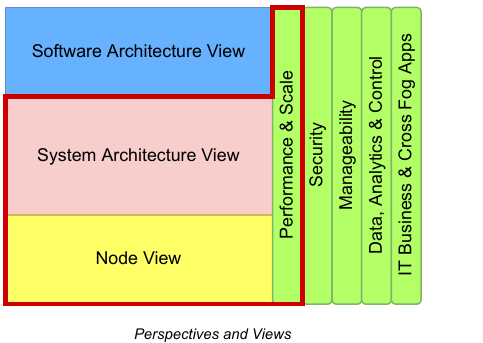
Figure 6. OpenFog reference architecture (adapted from